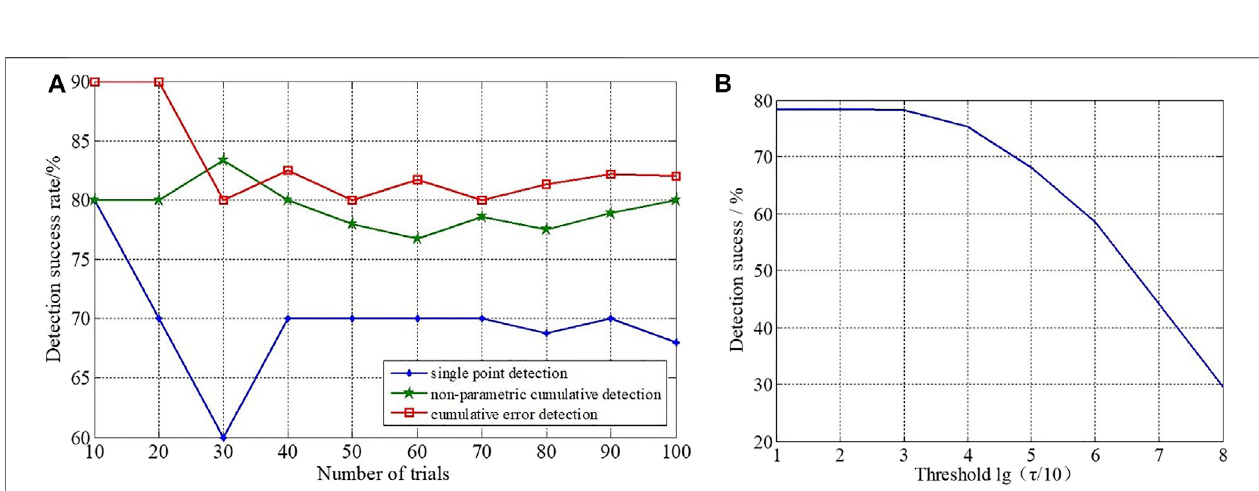
FIGURE 4 | Line chart. (A) comparison results of three detection methods. (B) The relationship between detection success rate and τ .